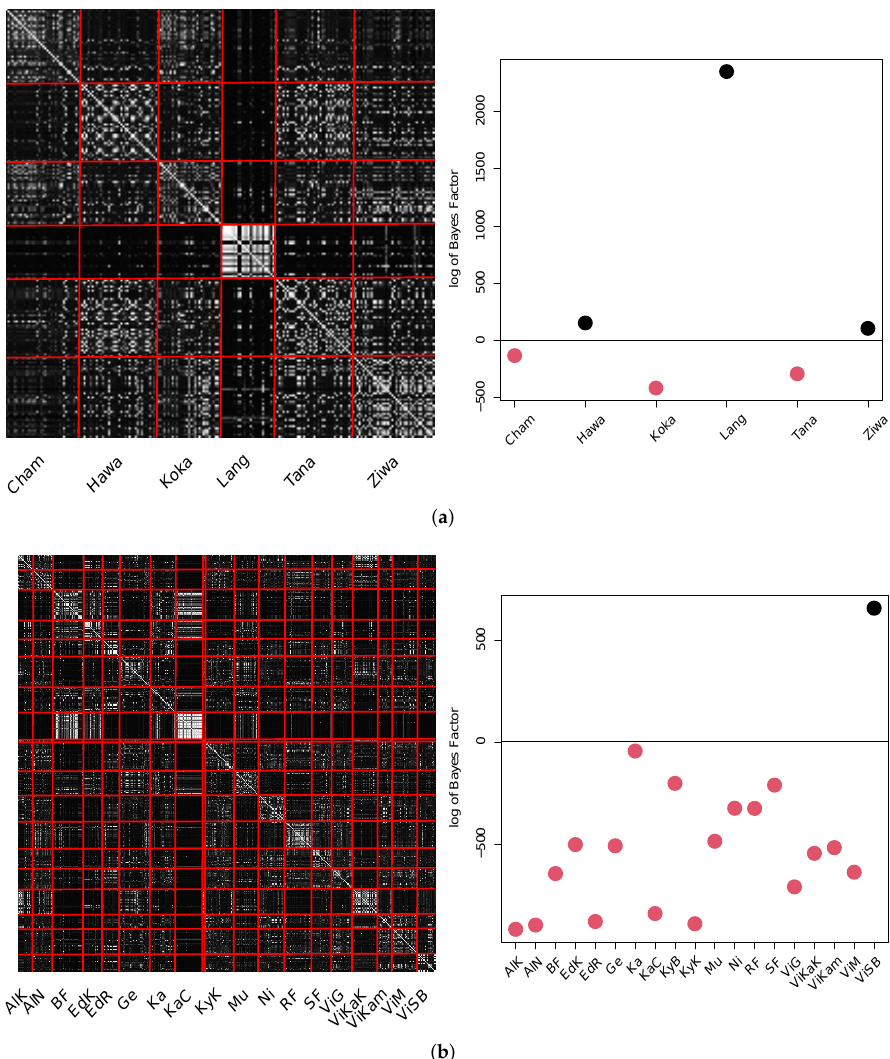
Figure 13. Visualization of the results obtained by pCA and the Bayes factor hypothesis test relying on GPA. Both pCA matrices show minor visible structure. Three of six locations of Ethiopia were found to be significantly different to the remaining populations. Similarly, one out of nineteen locations were identified to be significantly different in Uganda’s locations. ( a ) pCA and Bayes factor results for Ethiopia relying on GPA scaling. ( b ) pCA and Bayes factor results for Uganda relying on GPA scaling. The KyB population label in the pCA matrix was removed due to